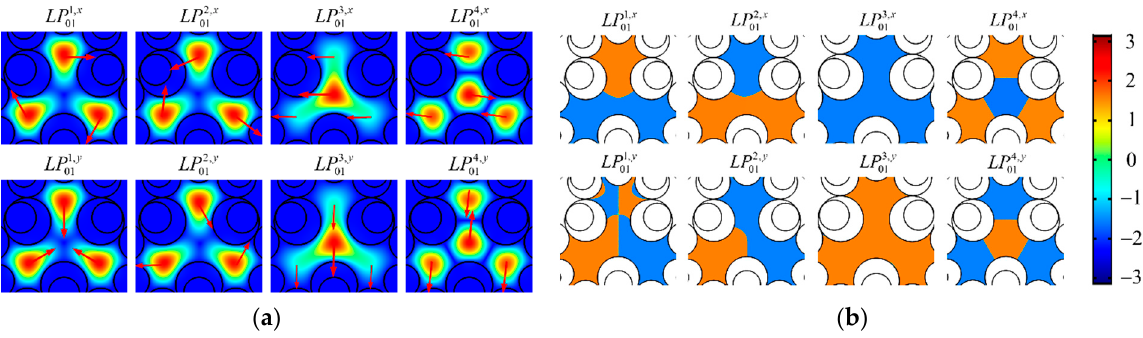
Figure 2. ( a ) Fundamental supermode electric field distribution of the four-core strongly coupled anti-resonant fiber, the direction of red arrows represents the direction of the electric field; ( b ) Fundamental supermode phase distribution of the four-core strongly coupled anti-resonant fiber and its color legend. Table 1. Parameter settings when calculating the influence of various g on CL and the coupling characteristics.